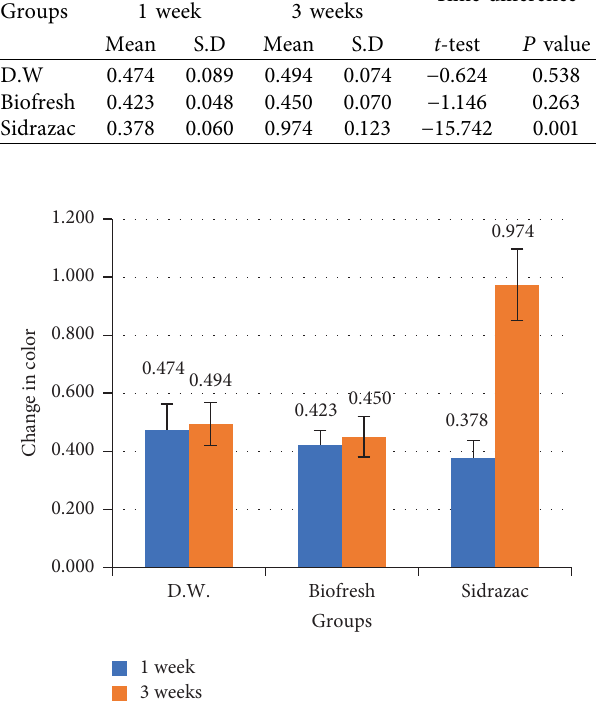
Figure 3: Color changes of rhodium-coated archwire after im- mersion in